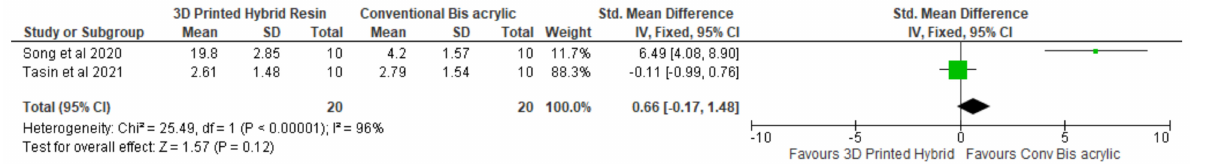
Figure 4. Forest plot comparing color change between 3D-printed hybrid resin and conventional PMMA